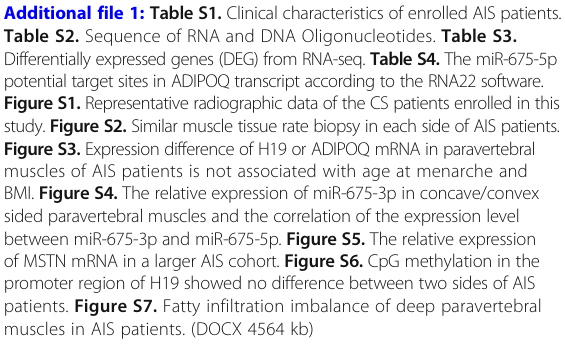
Additional file 1: Table S1. Clinical characteristics of enrolled AIS patients. Table S2. Sequence of RNA and DNA Oligonucleotides. Table S3. Differentially expressed genes (DEG) from RNA-seq. Table S4. The miR-675-5p potential target sites in ADIPOQ transcript according to the RNA22 software. Figure S1. Representative radiographic data of the CS patients enrolled in this study. Figure S2. Similar muscle tissue rate biopsy in each side of AIS patients. Figure S3. Expression difference of H19 or ADIPOQ mRNA in paravertebral muscles of AIS patients is not associated with age at menarche and BMI. Figure S4. The relative expression of miR-675-3p in concave/convex sided paravertebral muscles and the correlation of the expression level between miR-675-3p and miR-675-5p. Figure S5. The relative expression of MSTN mRNA in a larger AIS cohort. Figure S6. CpG methylation in the promoter region of H19 showed no difference between two sides of AIS patients. Figure S7. Fatty infiltration imbalance of deep paravertebral muscles in AIS patients. (DOCX 4564